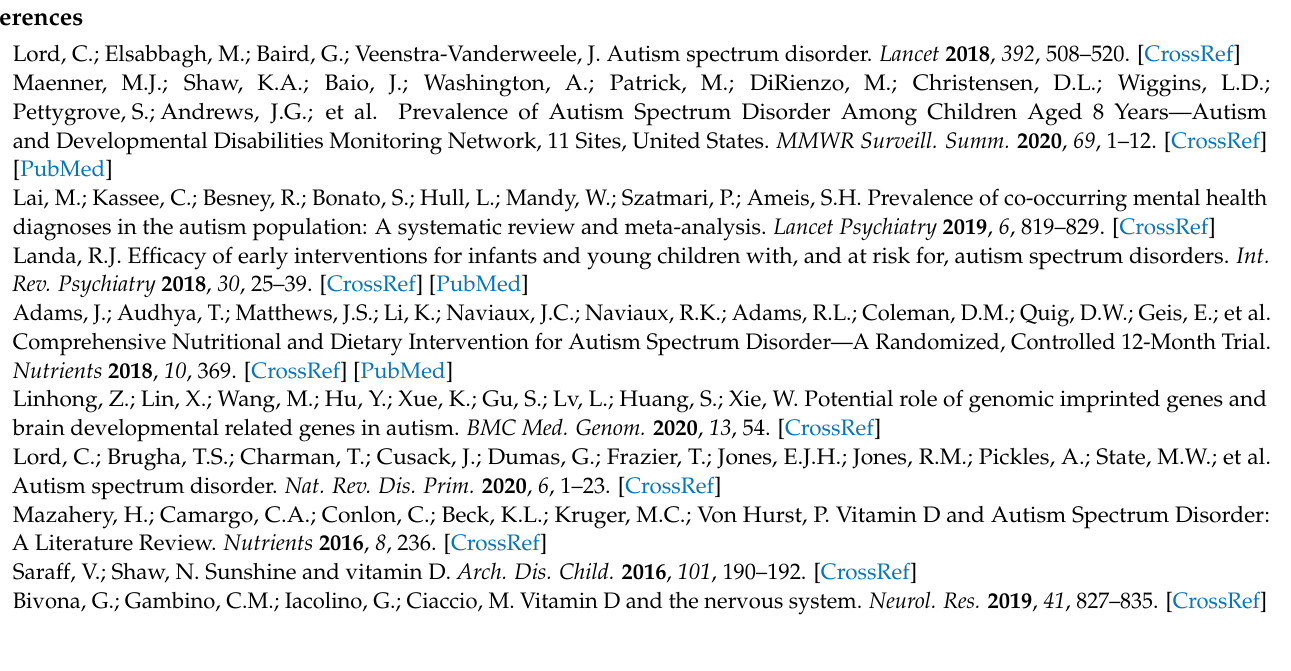
Table S5: Subgroup analysis of case–control studies; Table S6: Subgroup analysis of case–control studies reporting OR; Table S7: Subgroup analysis of case–control studies barring data from previous meta-analysis; Table S8: Subgroup analysis of studies measuring maternal and neonatal vitamin D concentration; Table S9: Subgroup analysis of prospective studies reporting OR; Figure S1: Funnel plot and Egger and Begg test of meta-analysis of 24 case–control studies; Figure S2: Funnel plot and Egger and Begg test of meta-analysis of 10 case control studies; Figure S3: Funnel plot and Egger and Begg test of meta-analysis of 15 case control studies; Figure S4: Funnel plot and Egger and Begg test of meta-analysis of seven studies reporting maternal and neonatal vitamin D concentration; Figure S5: Funnel plot and Egger and Begg test of meta-analysis of nine prospective studies reporting